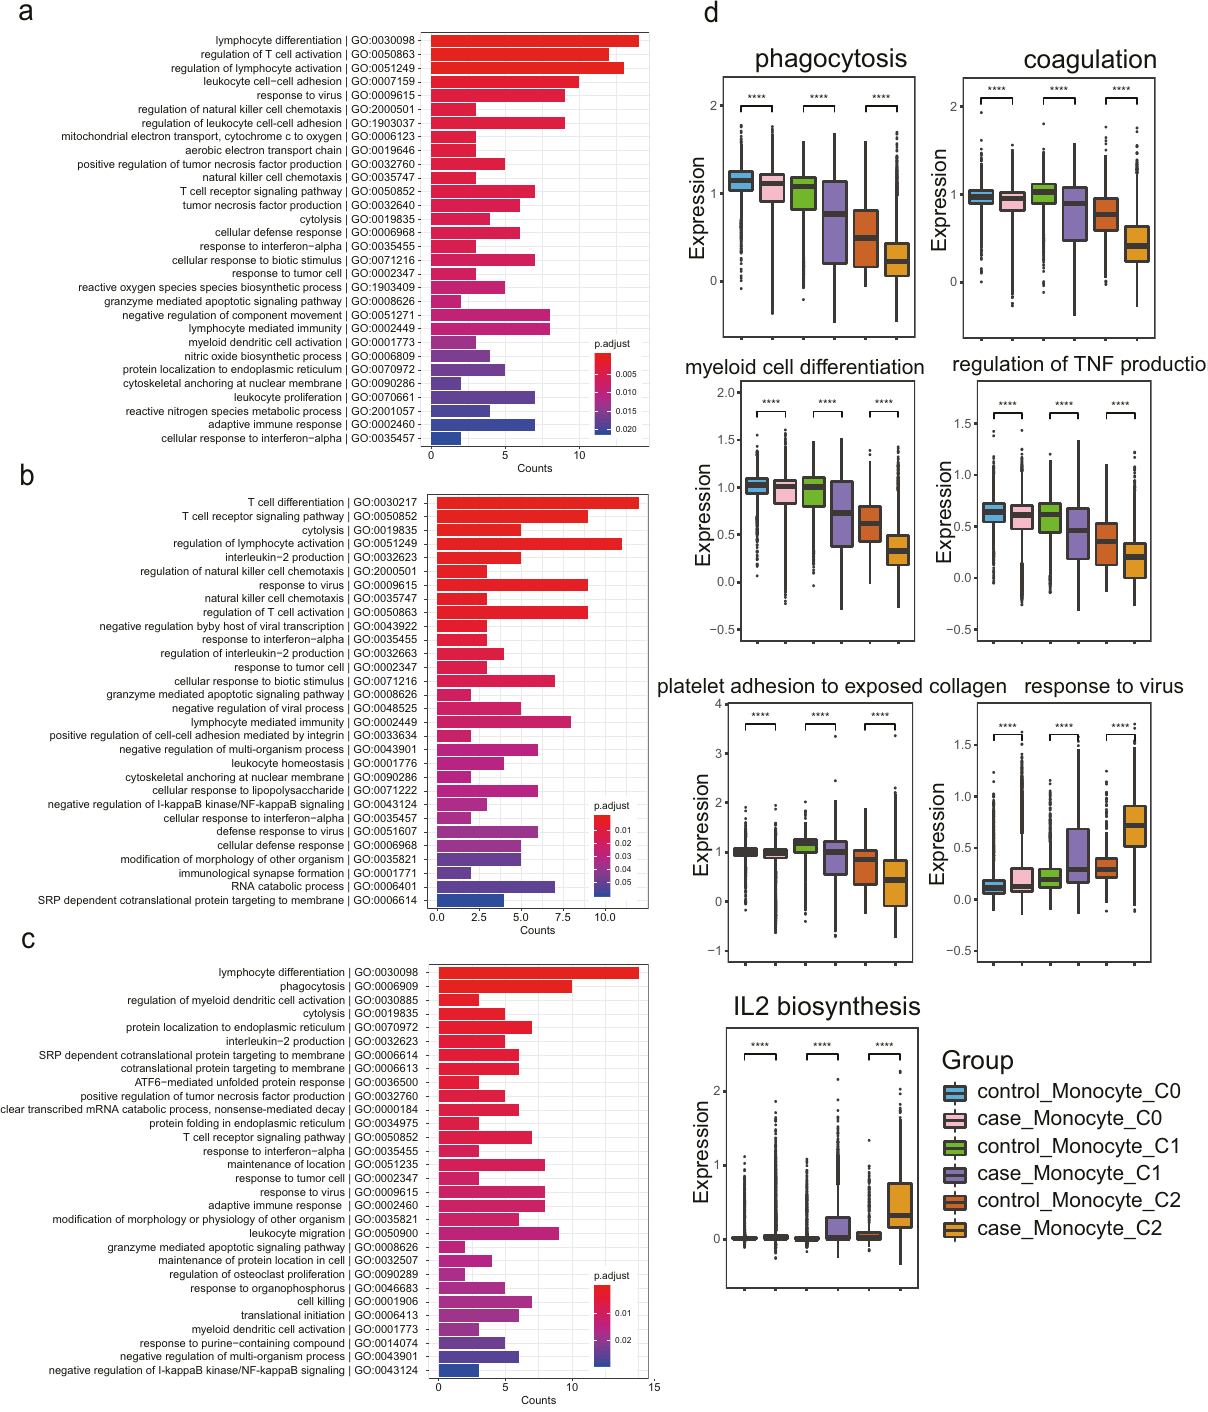
Fig. 4 | Differential biological pathways in each monocyte cluster between HAPH patients and controls. Gene Ontology analysis (biological process) of the DEGs in C0 ( a ), C1 ( b ) and C2 ( c ) monocytes between the HAPH and control sam- ples. d Boxplot showing the mean pathway signature score of each monocyte